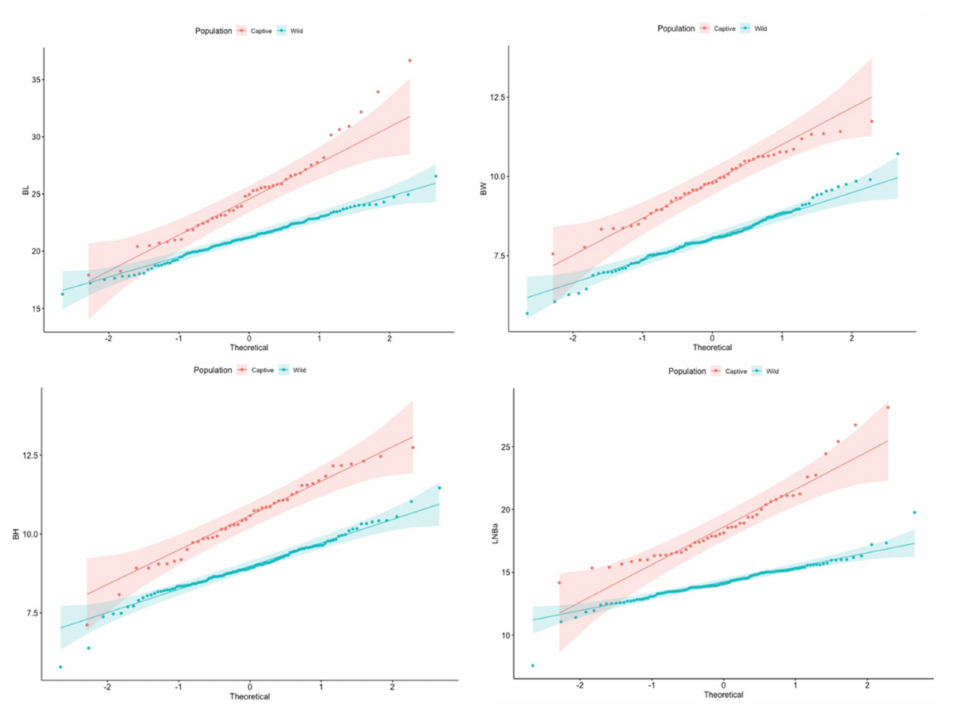
Figure 3. Visual inspection of the Q-Q plots of morphometric data of the wild and captive populations for each bill character.